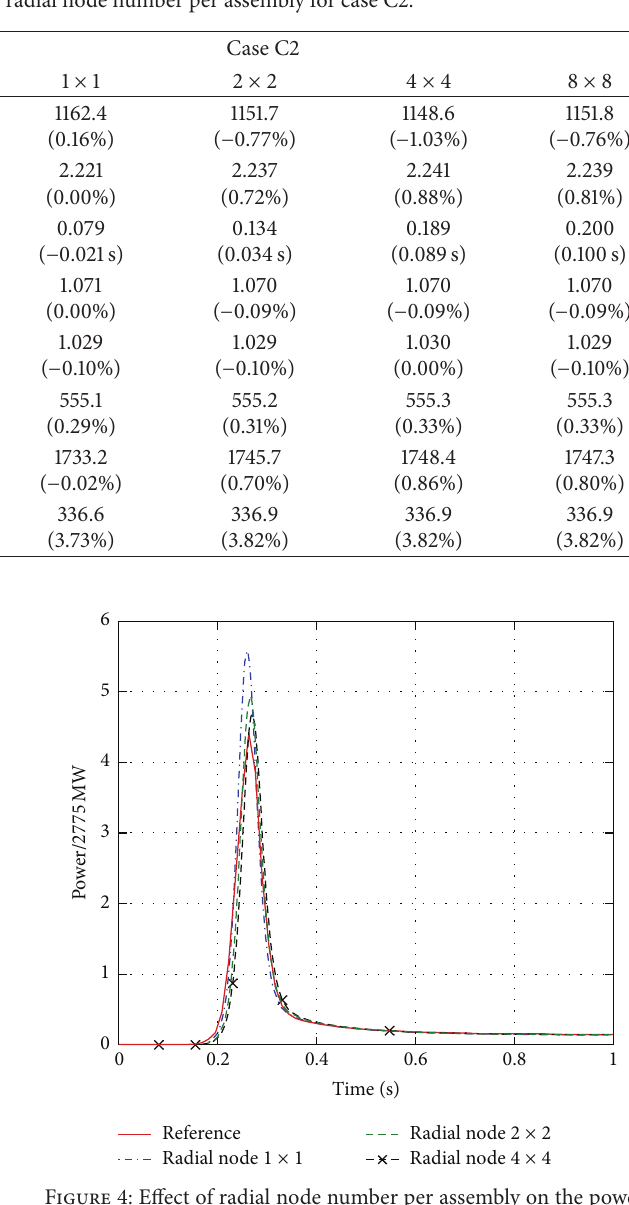
Figure 3: Effect of the radial node number per assembly on the power peak for case A1.